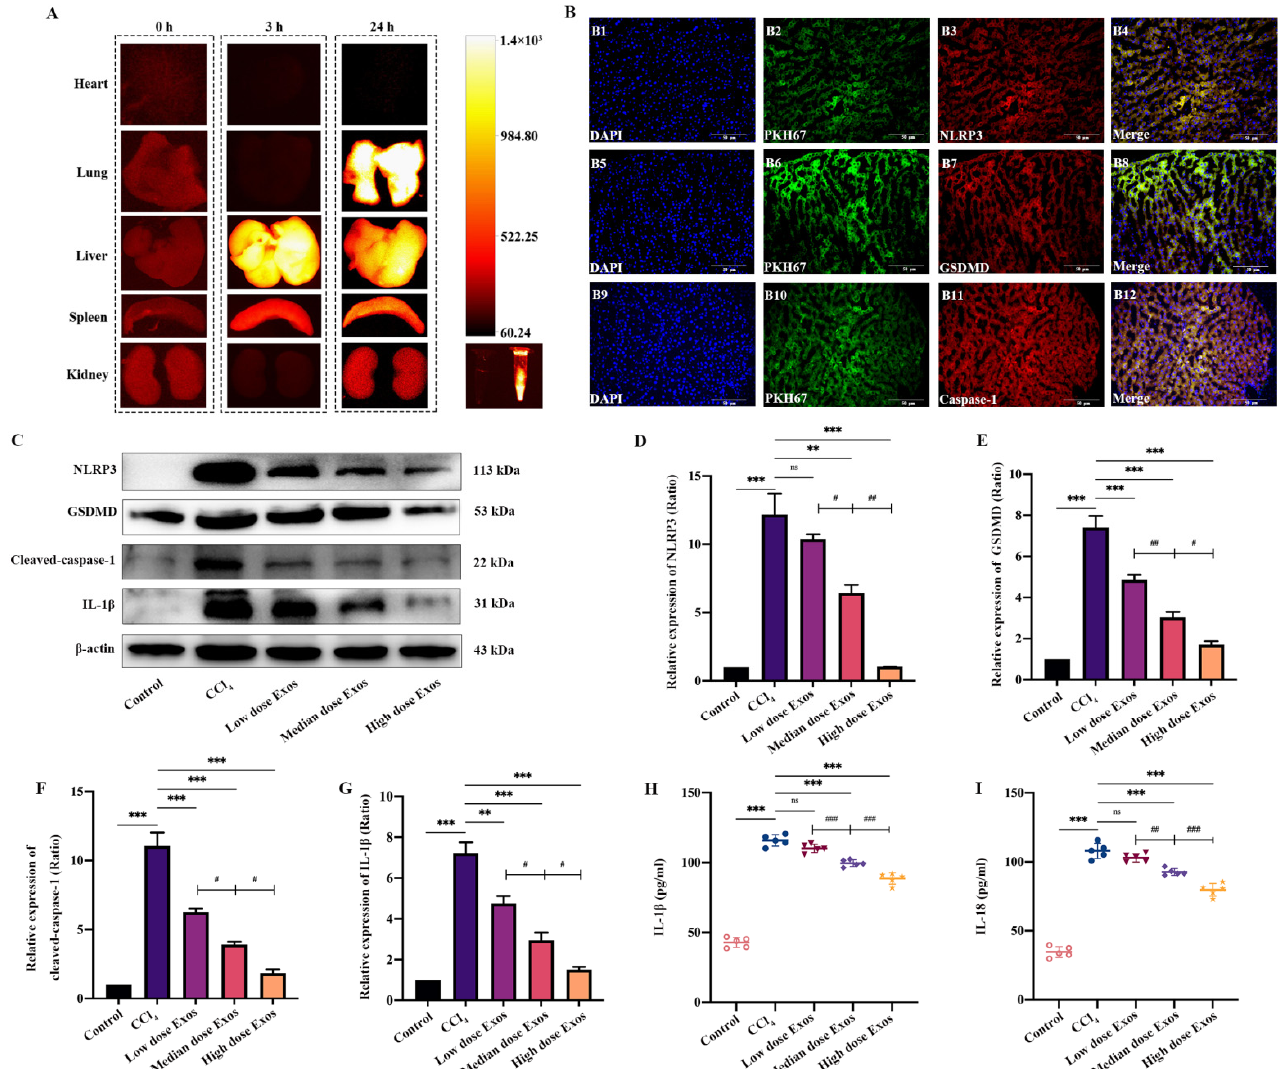
Figure 4. Distribution of Exos-rBMMSC and the therapeutic effect on liver cirrhosis. The distribution of Exos was examined by NIRF at 0 h, 3 h and 24 h post-injection. At 3 h post-injection, Exos were mainly concentrated in the liver and were mainly concentrated in the liver and lung at 24 h post-injection ( A ). The colocalization of NLRP3, GSDMD and caspase-1 with PKH67 dye is shown in ( B ), scale bar = 50 μ m. Compared to that in the CCl 4 group, NLRP3, GSDMD, cleaved caspase-1, and IL-1 β expression in the medium and the high Exos groups was dramatically decreased (( C – G ), ** p < 0.01). The expression of NLRP3 in the low dose Exos-rBMMSC group was not significantly different from that in the CCl 4 group (( D ), p > 0.05). The expression of GSDMD, cleaved-caspase-1 and IL-1 β in the low dose Exos group was dramatically decreased compared to that in the CCl 4 group (( E – G ), ** p < 0.01). The expression of NLRP3, GSDMD, cleaved-caspase-1 and IL-1 β in the medium dose Exos group was significantly higher than that in the high dose Exos-rBMMSC group (( C – G ), # p < 0.05). IL-1 β and IL-18 expression in the medium and high dose Exos-rBMMSC groups was dramatically lower than that in the CCl 4 group (( H , I ), *** p < 0.001), while the expression in the low dose Exos-rBMMSC group was not different from that in the CCl 4 group (( H , I ), p > 0.05). IL-1 β and IL-18 expression in the medium dose Exos group was significantly lower than that in the low dose Exos group but was higher than that in the high dose Exos group (( H , I ), ## p < 0.01). The data are displayed as the means ± SD; n = 5 for each group.